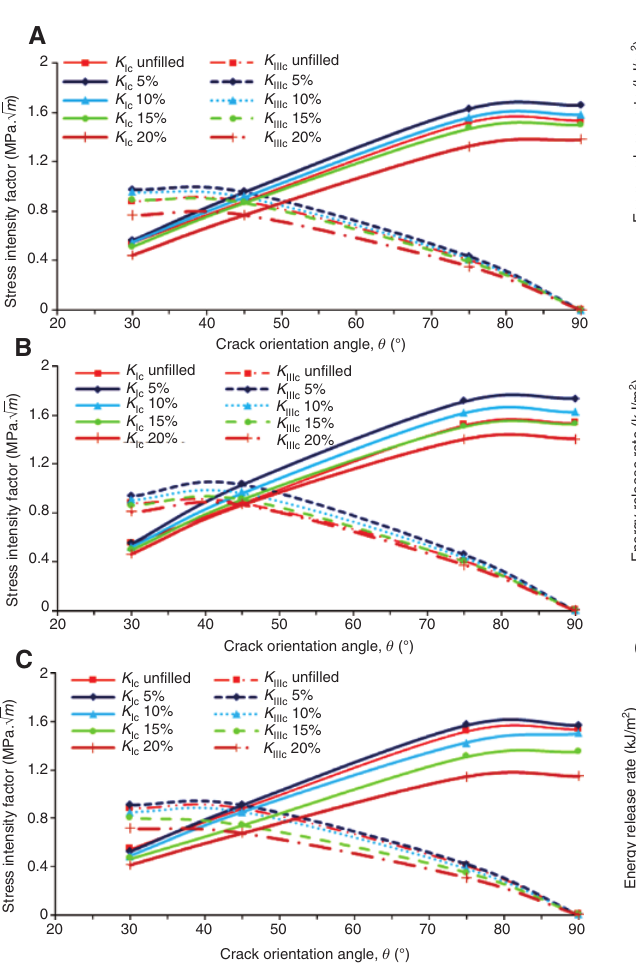
Figure 8: Mode I and mode III critical stress intensity factors of (A) SSA, (B) FA, and (C) SiC filled polyester composites.